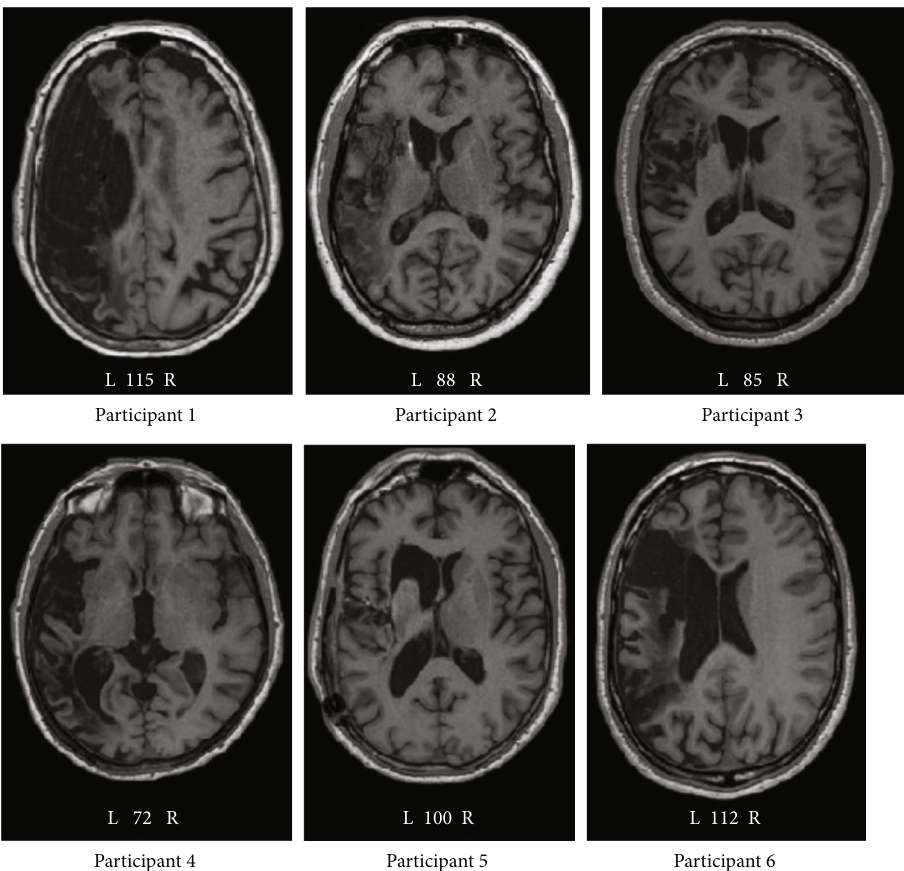
Figure 1: Brain MRI scans (axial plane) of the participants. Key: L: left hemisphere; R: right hemisphere; numbers indicate serial axial slice